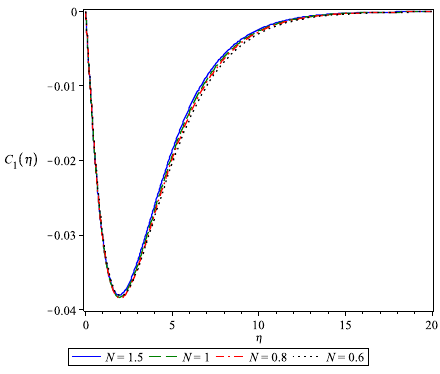
Figure 4. Dependency of concentration profile C 1 on the magnetic parameter N when Sc = 0.24 and K =